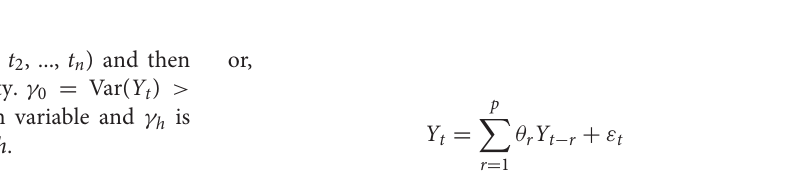
multivariate normal for all time points ( t 1 , t 2 , ..., t n ) and